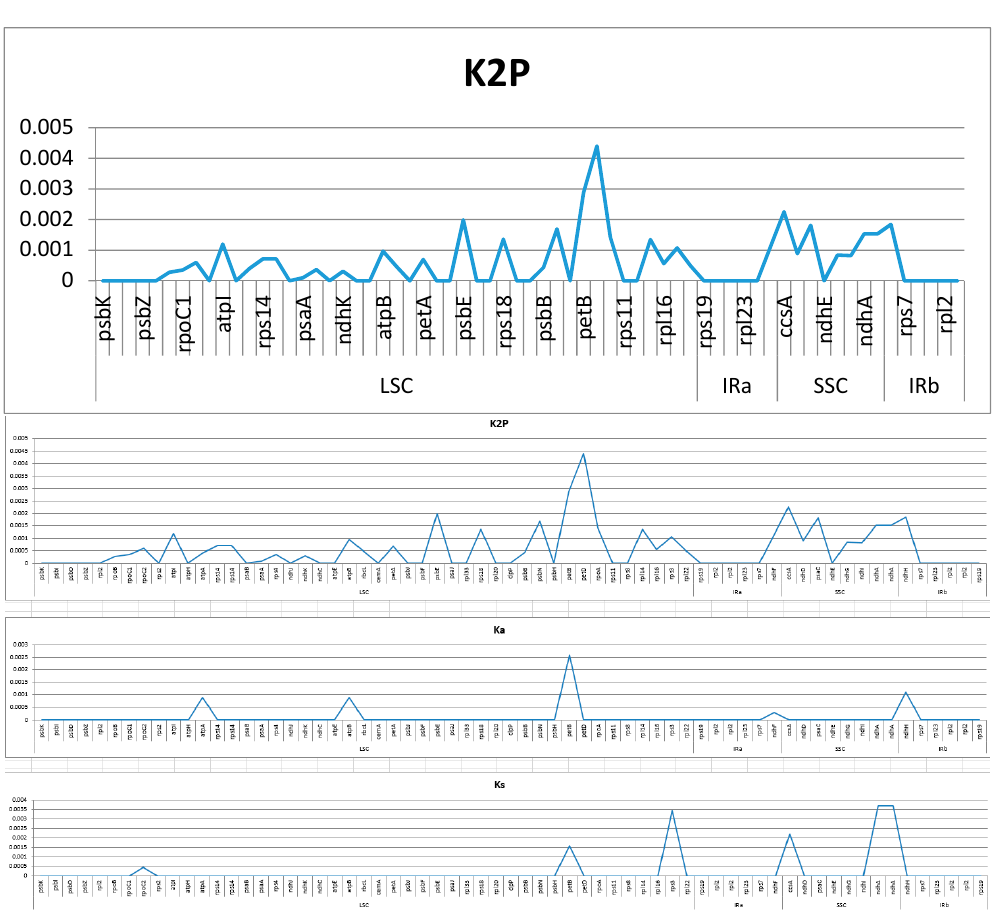
Figure 5. The K2P, Ka and Ks values of the 65 protein-coding genes in high divergent regions from two sugarcane ancestors of Saccharum officinarum and S. spontaneum.